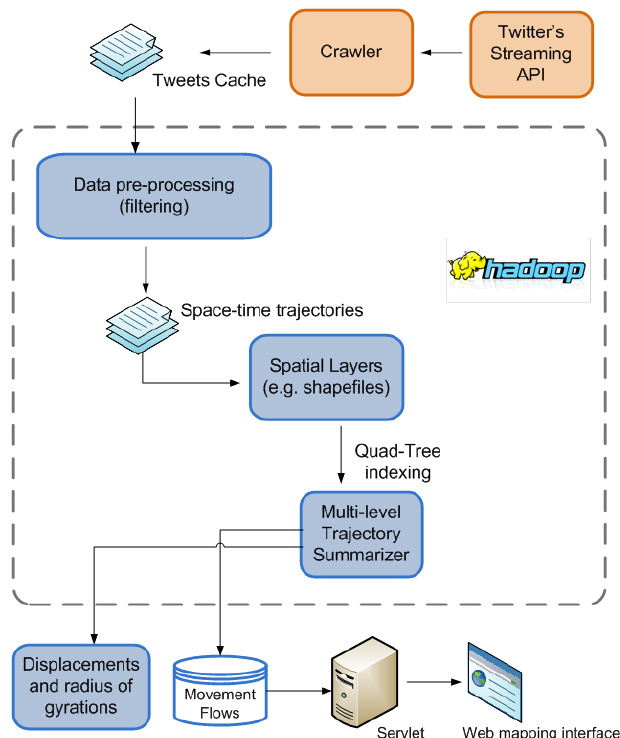
Figure 1. The overall system architecture of the